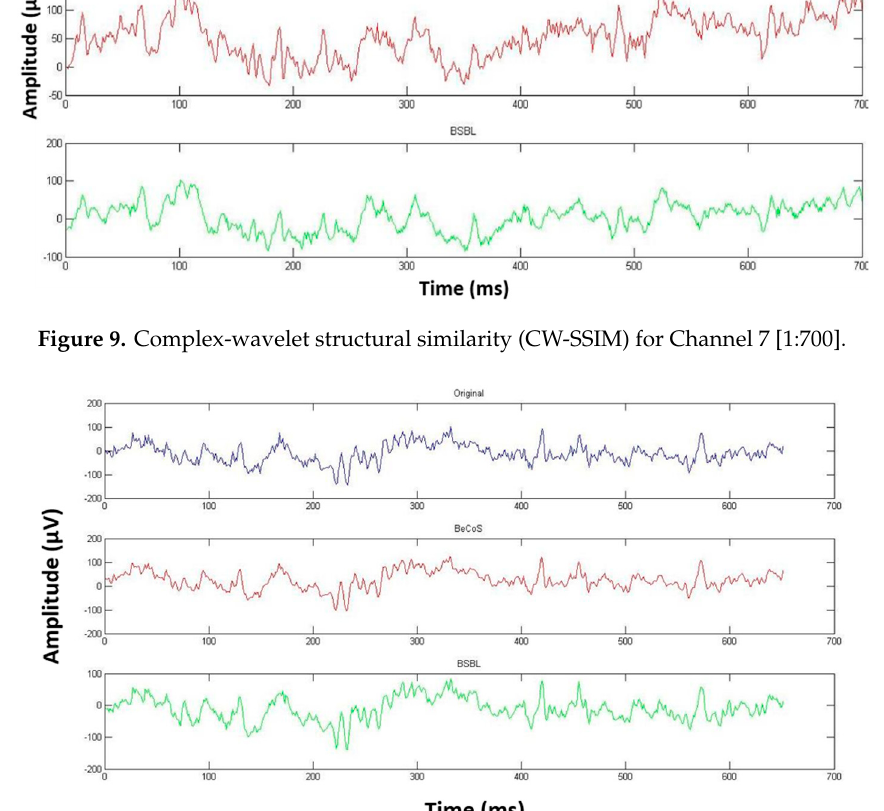
Table 5. Effect of numerical methods on signal reconstruction.